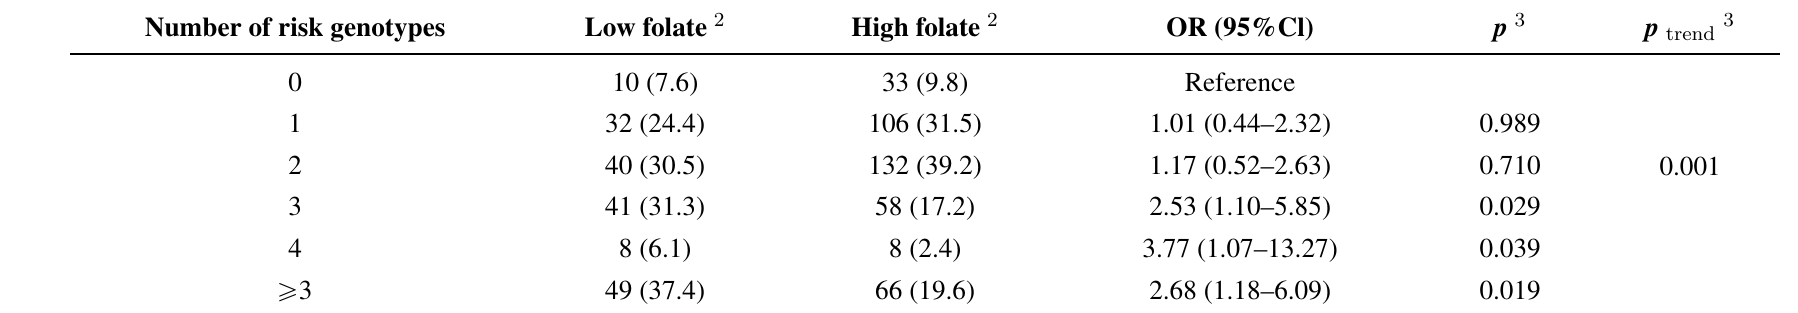
Table 7. Cumulative effects of risk genotypes 1 on folate